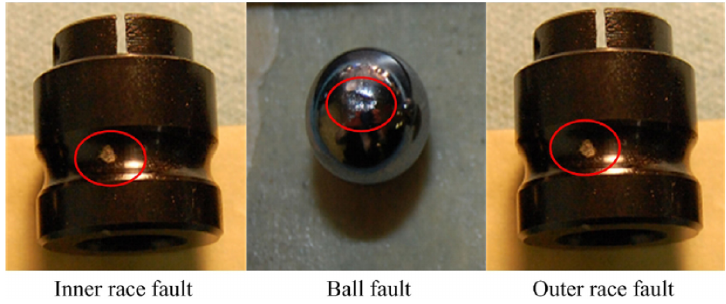
Figure 3. Bearings with different faulty conditions.